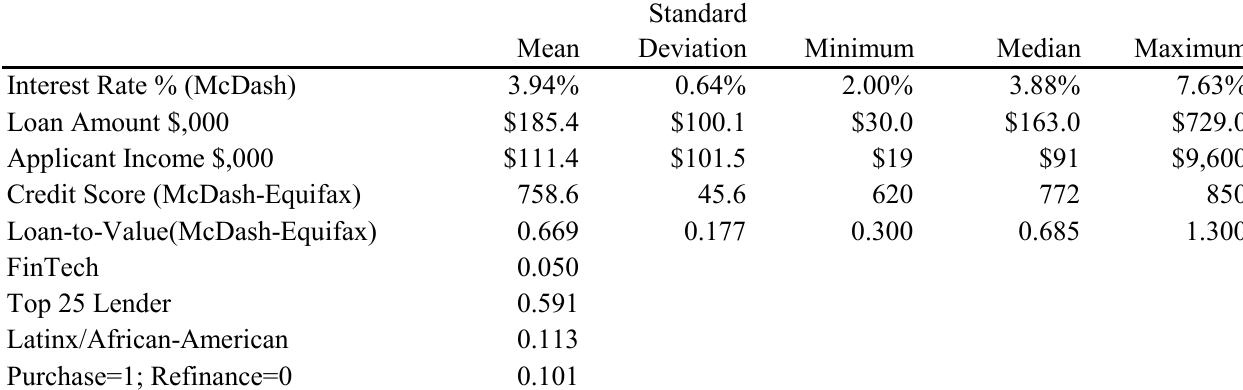
Appendix Table 1: Statistics & Estimation of Interest Rate Discrimination for Shorter